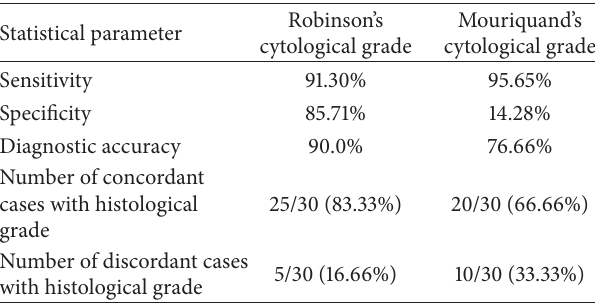
Table 4: Comparison of statistical parameters and concordance of the two cytological grading methods with histological grading